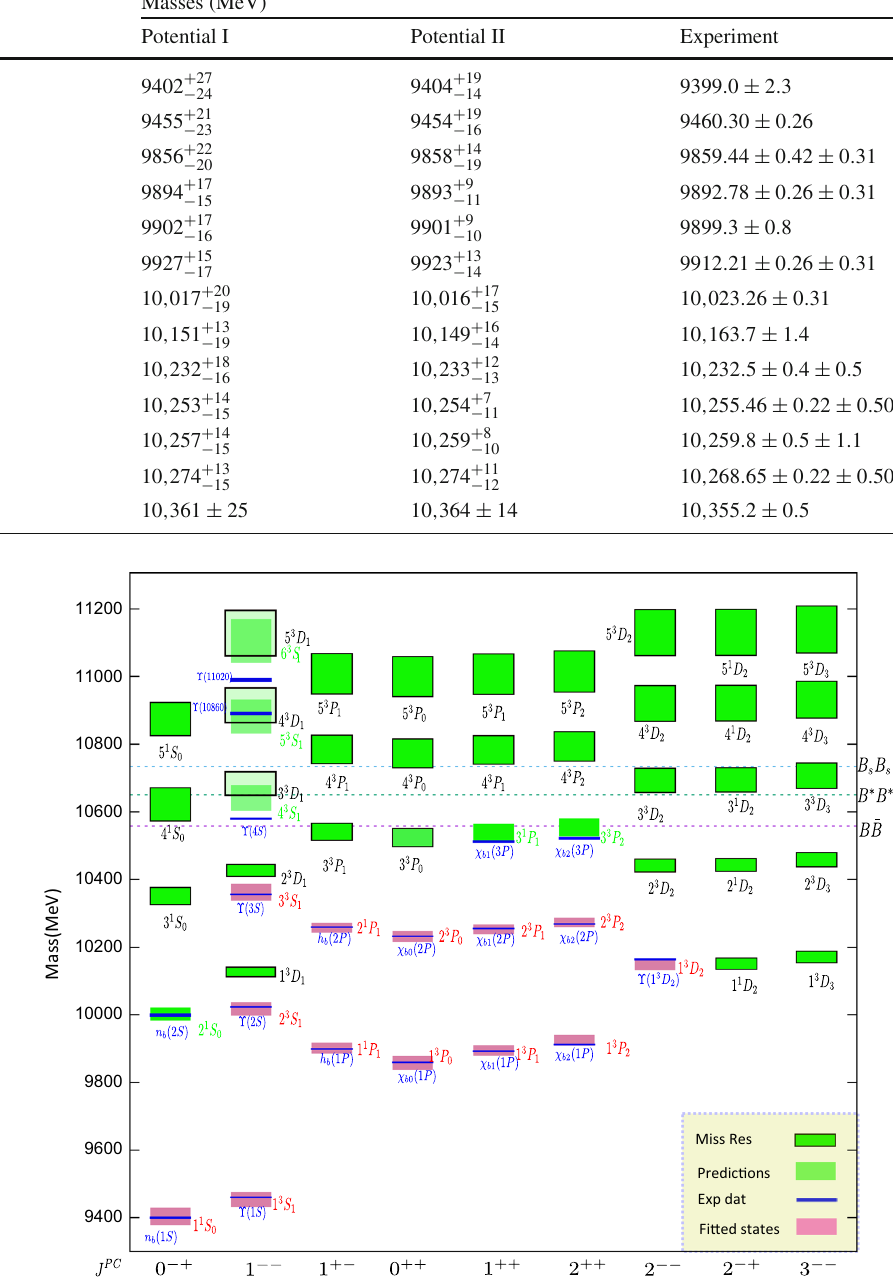
Table 1 Fitted bottomonia for potentials I and II compared to the PDG values; n stands for the principal quantum number, L for the orbital angular momentum, J for the total angular momentum, and S for the